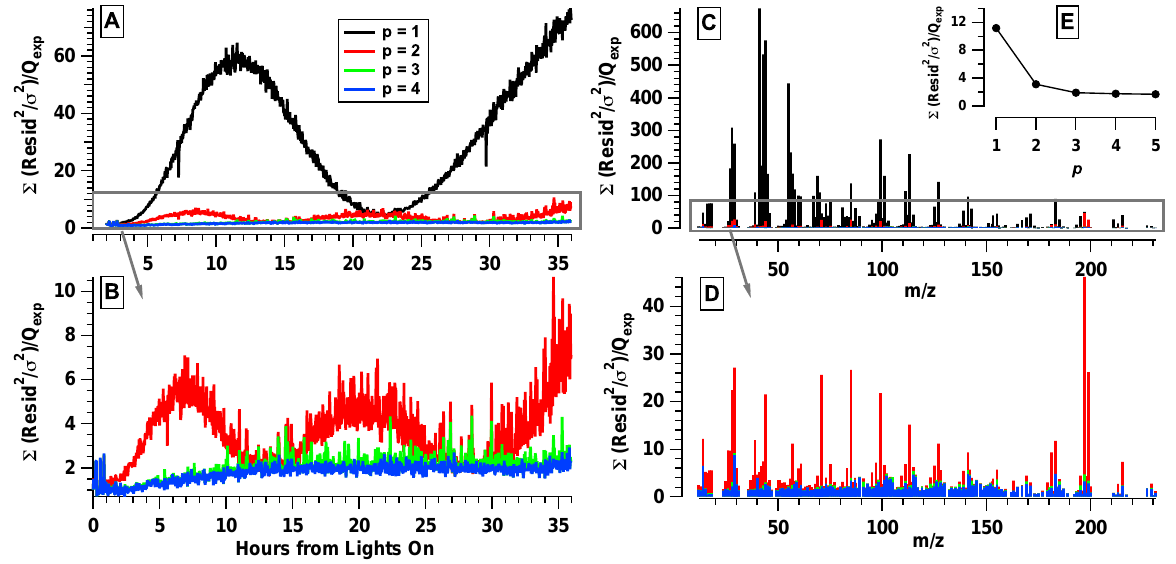
Fig. A4. The ratio of Q/Q expected for p = 1, 2, 3, and 4 is used as a diagnostic in determining the number of factors in PMF analysis. Time series trend of Q/Q expected for p = 1 through p = 4 solutions (A) and (B) clearly show that at least three factors are needed to describe the solution. The difference between the p = 3 and 4 solutions is minor, with the p = 4 solution having the same trend as the p = 3, but with less noise. The Q/Q expected at each m/z for p = 1 through p = 4 solutions and (C) and (D) show similar results, just for the m/z dependence. The overall time trend and m/z contributions to the Q/Q expected at each factor are also presented (E)